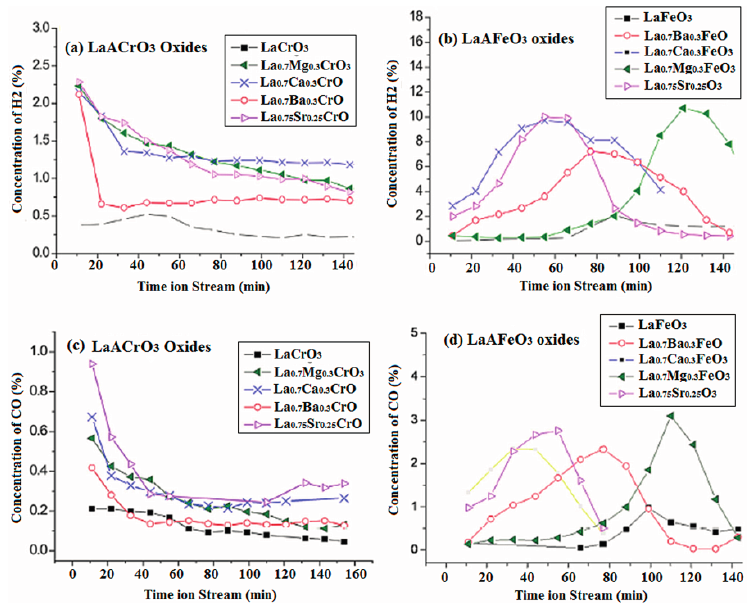
at 850 °C and GHSV = 750 h − 1 4